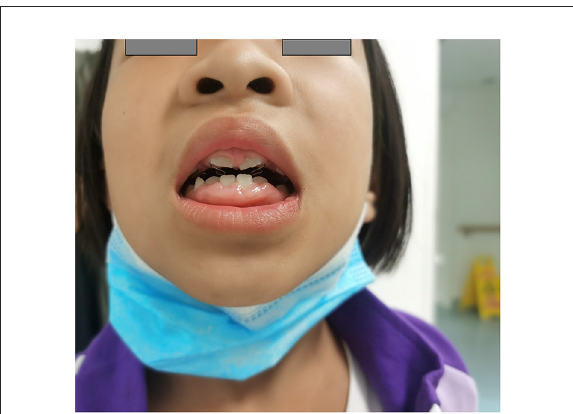
FIGURE1 A patient with severe gingival hyperplasia. Female, 3 years old at diagnosis, treated with diltiazem at the maximum dose of 34.3 mg/kg/day, gingival hyperplasia is severe, companied with dental